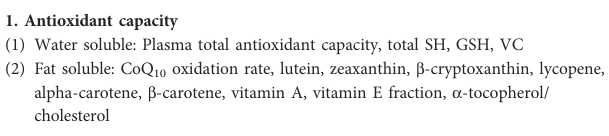
TABLE 1 Biomarkers of oxidative stress and